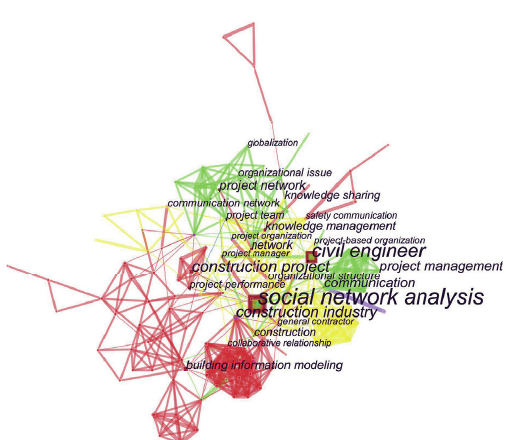
Figure 3: Keywords cooccurrence network